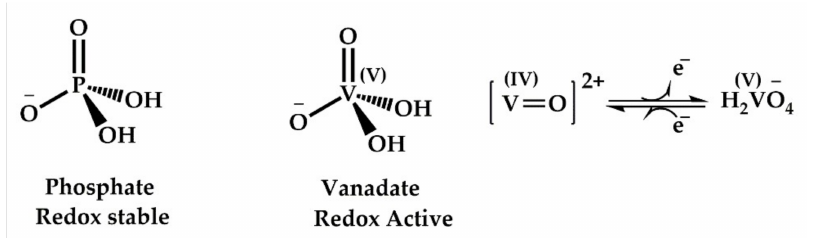
Figure 6. Structural similarity between phosphate and vanadate at physiological pH and the redox conversion between V (IV) and V (V) oxidation